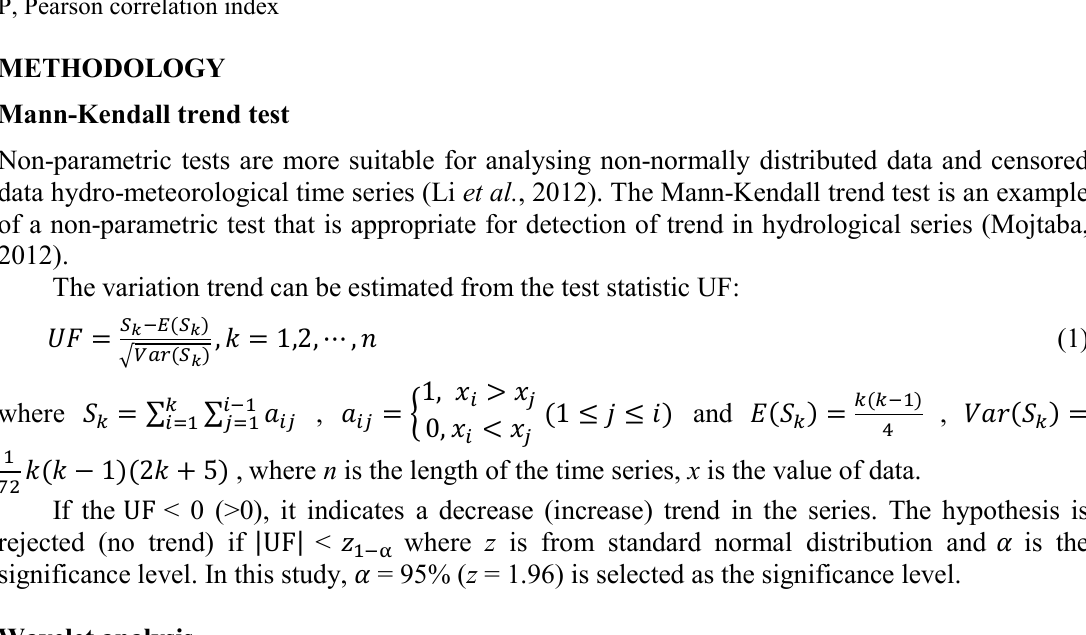
Table 1 Correlation coefficients between the simulated and in situ soil moisture data. Station Latitude (N) Longitude (E) P Huanxian 36°34′ 107°18′ 0.66 Guyuan 36°00′ 106°16′ 0.69 Xifengzh 35°44′ 107°38′ 0.59 Tongwei 35°13′ 105°14′ 0.71 Tianshui